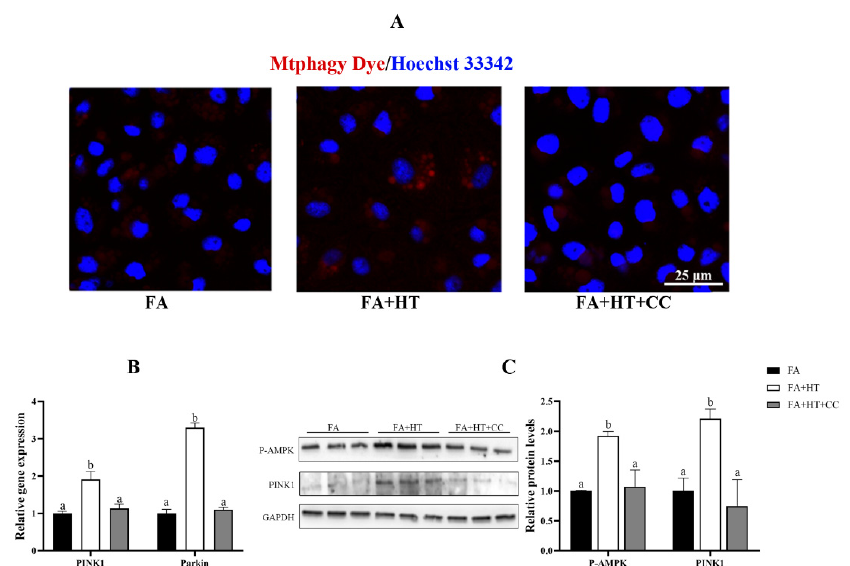
Figure 8. Staining of fat droplet by BODIPY 493/503 (green) in ZFL cell ( A ). Nuclei are highlighted with Hoechst 33342 (blue), scale bar = 25 µ m ( A ). Citrate synthase ( B ) and succinate dehydrogenase (CS: ( C )) activities and ATP content (SDH: ( D )) in ZFL cell. Values are shown as mean ± SE (n = 3). FA group—FA medium; FA + HT group—FA medium containing 50 μ M HT; FA + HT + Csa group—FA medium containing 50 μ M HT with Csa pretreatment. All values are exhibited as mean ± SE. The values with different superscripts (a, b, c) are significantly different at p < 0.05 (Tukey’s test).